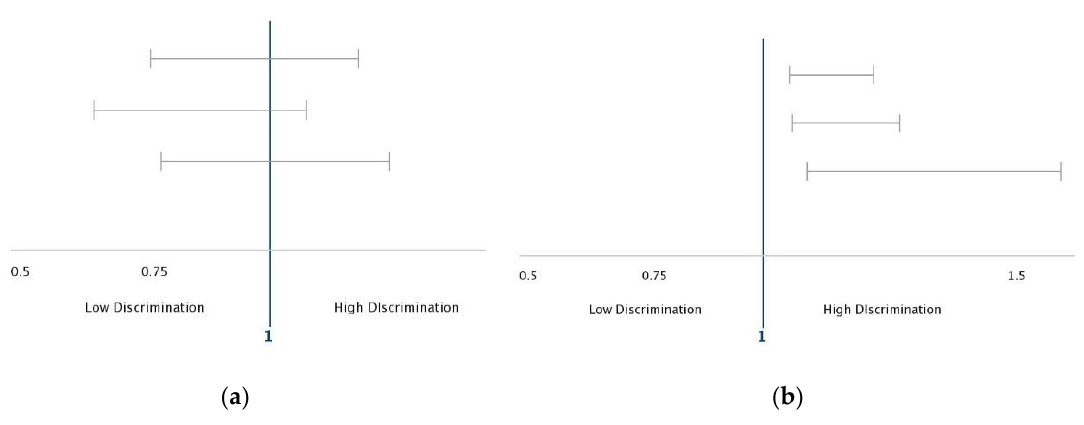
Figure 1. Association between perceived discrimination and depression in low and high SES groups. ( a ) Low SES; ( b ) High SES.